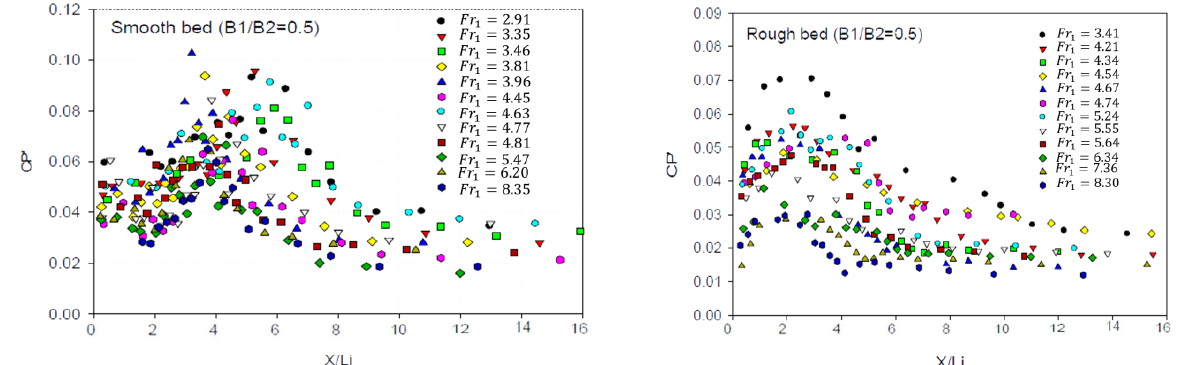
Figure 6. 𝐶 𝑃′ parameter for expansion ratio of 0.67. Figure 6. C P (cid:48) parameter for expansion ratio of 0.67.